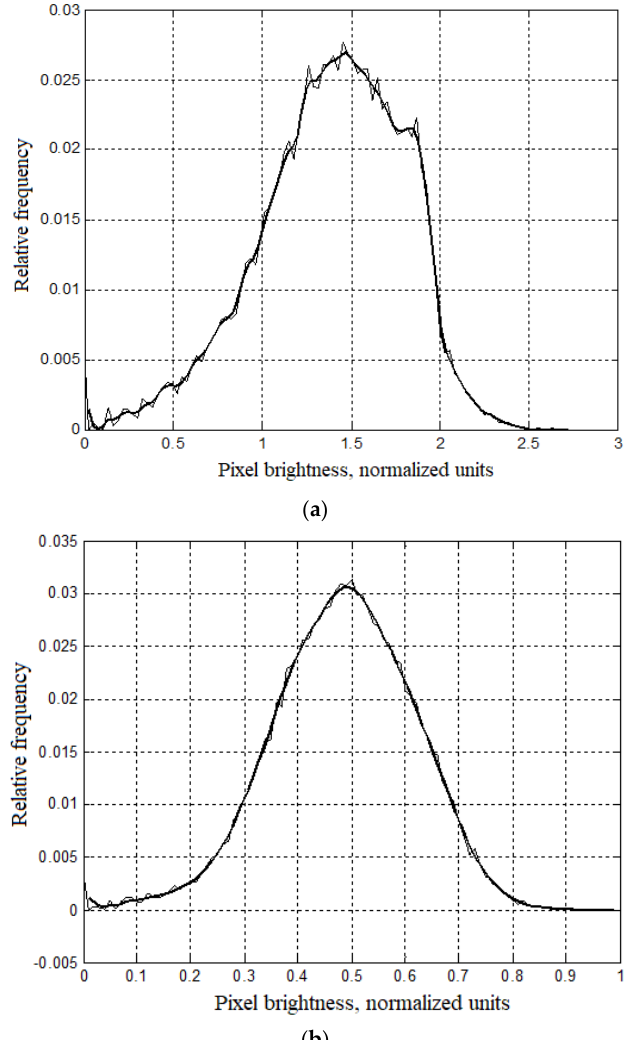
Figure 6. Histograms of images of Helder exponents (Algorithm Step 2.4): ( a ) — MPI – 1; ( b ) — MPI – 2.